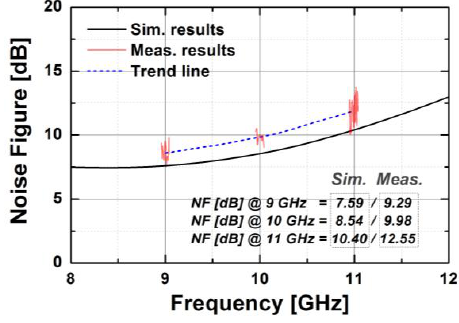
Figure 20. The measured S-parameters of the implemented TRM.